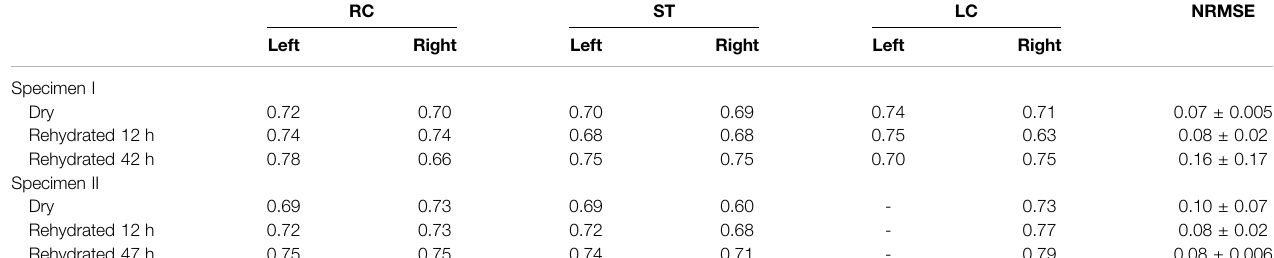
TABLE 1 | Edge sharpness analysis. FWHM for the edges indicated in Specimen I ( Figure 3D ) and Specimen II ( Figure 3E ). RC — right cortex (purple in Figures 3D,E ), ST — soft tissue (red in Figures 3D,E ), LC — left cortex (purple in Figures 3D,E ). A lower FWHM indicates a sharper edge.